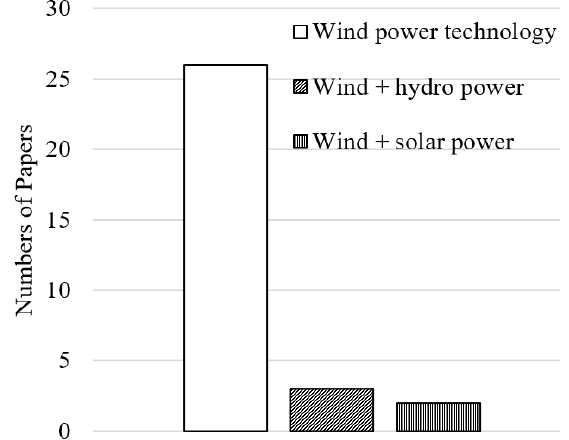
Figure 7. Consideration of renewable energy resources in the studied literature.